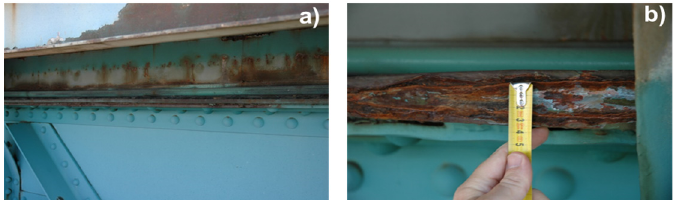
Figure 1. Corrosion of steel in a bridge: ( a ) general view; ( b ) detail of the thickness of the corrosion layer formed.